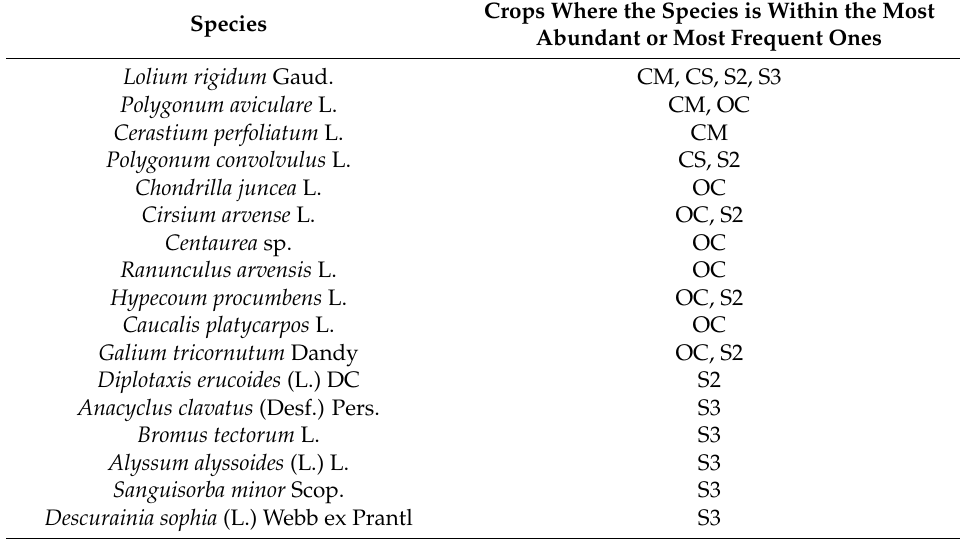
Table 5. Species with highest frequency and soil cover (%) in the different crops in all four sampling years. CM: cereal monocrop, CS: cereal after sainfoin, OC: organic cereal, S2: sainfoin second year, S3: sainfoin third